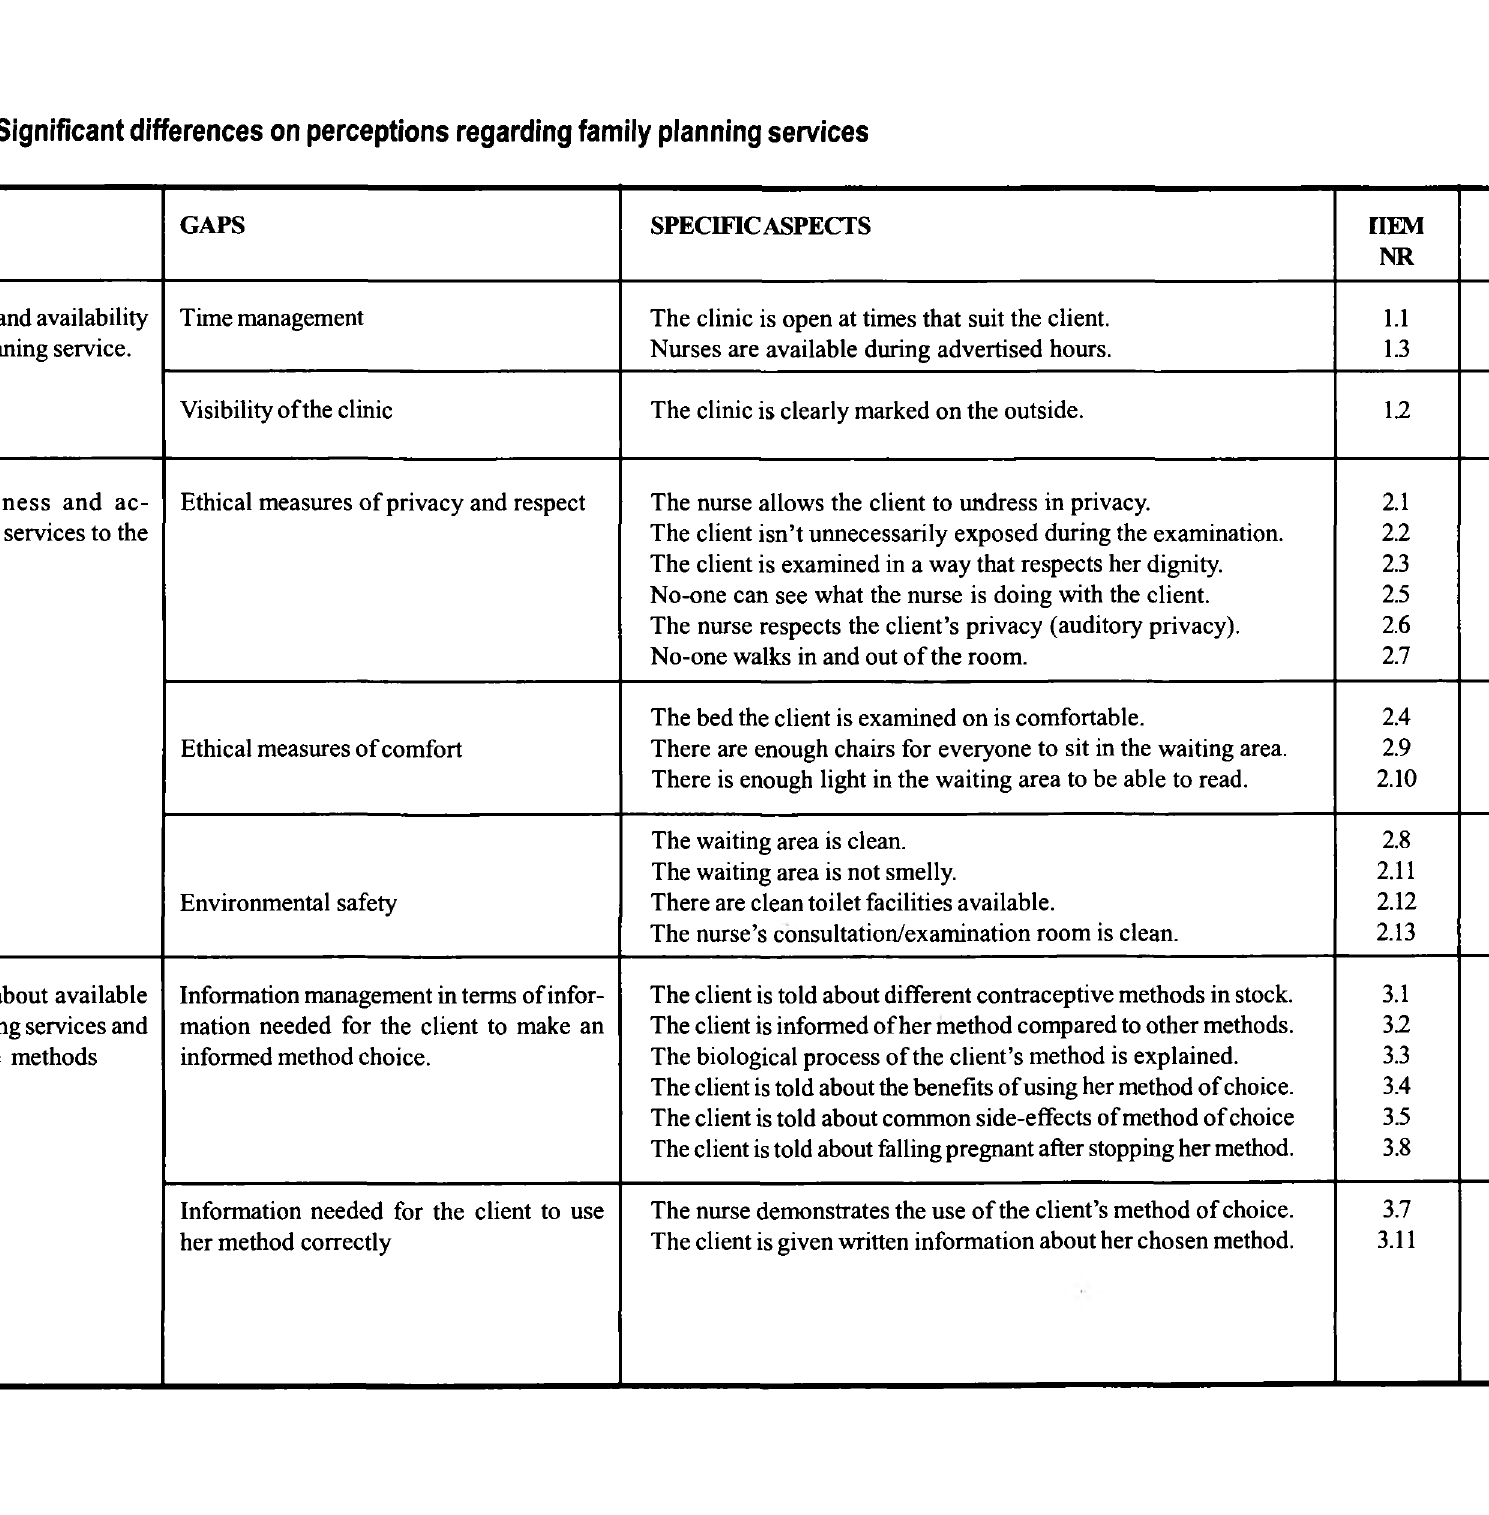
Table 3: Significant differences on perceptions regarding family planning